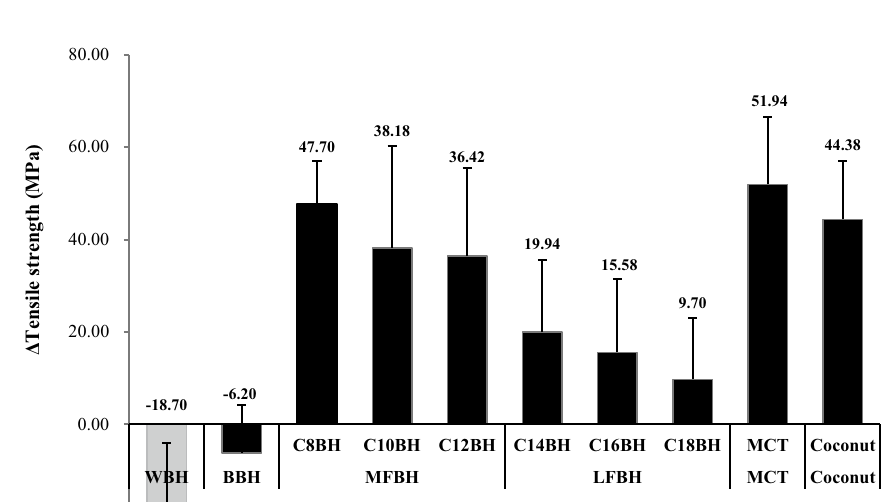
Fig. 6 Comparison of the tensile strength difference of 21-day vs. 0-day among bleached hair (BH) treated with different hair